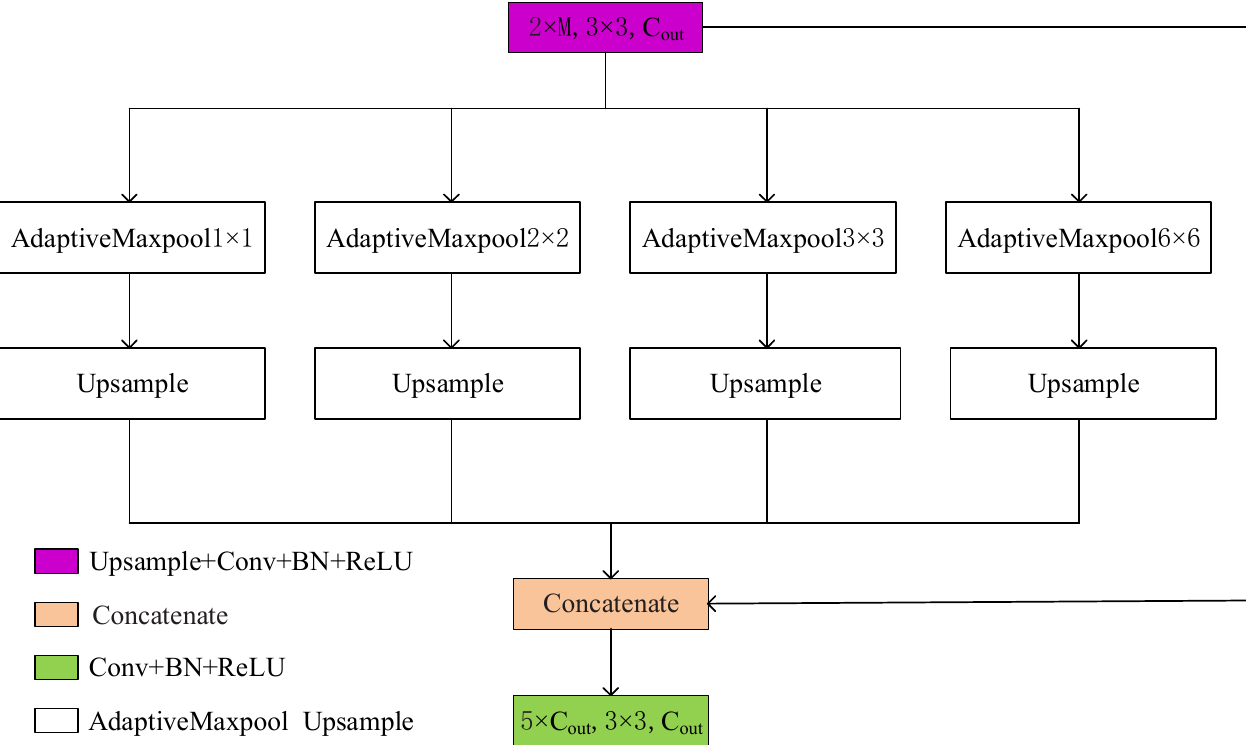
Figure 4. Pyramid ‐ like pooling module for 2DU 2 ‐ Net †. Figure 4. Pyramid-like pooling module for 2DU 2 -Net